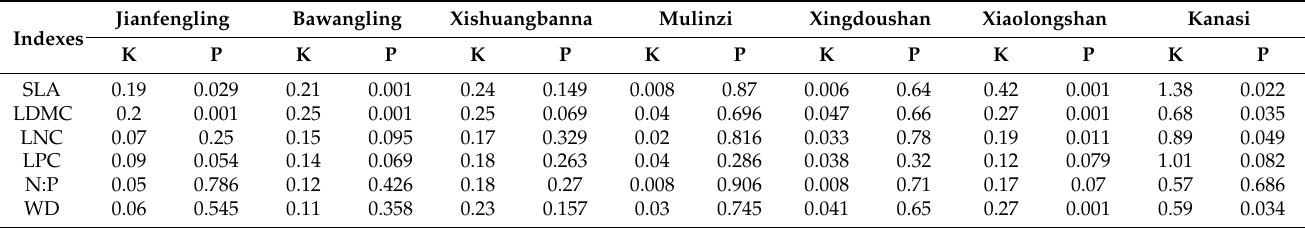
Table A1. The phylogenetic signal of functional traits in forest communities occupying different climatic zones in